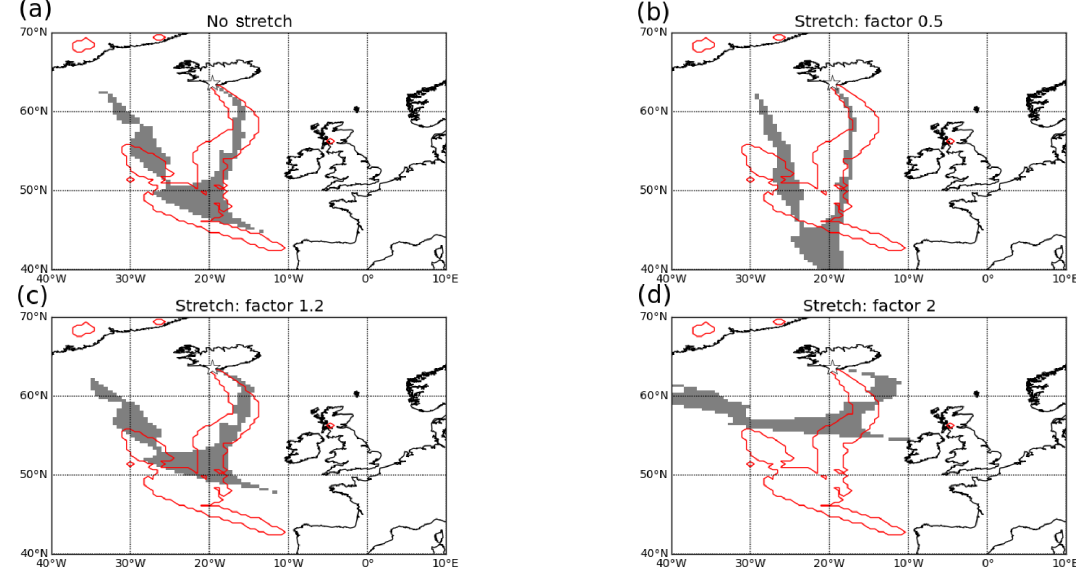
Figure 5. As Fig. 4 for 21:00UTC 7 May